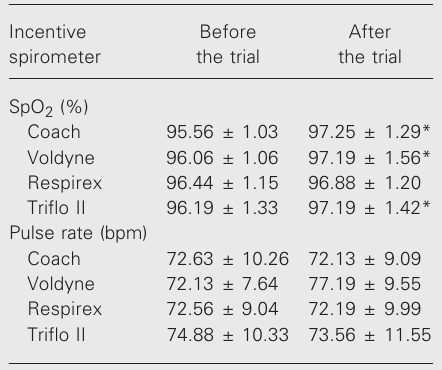
Data are reported as means ± SD for 16